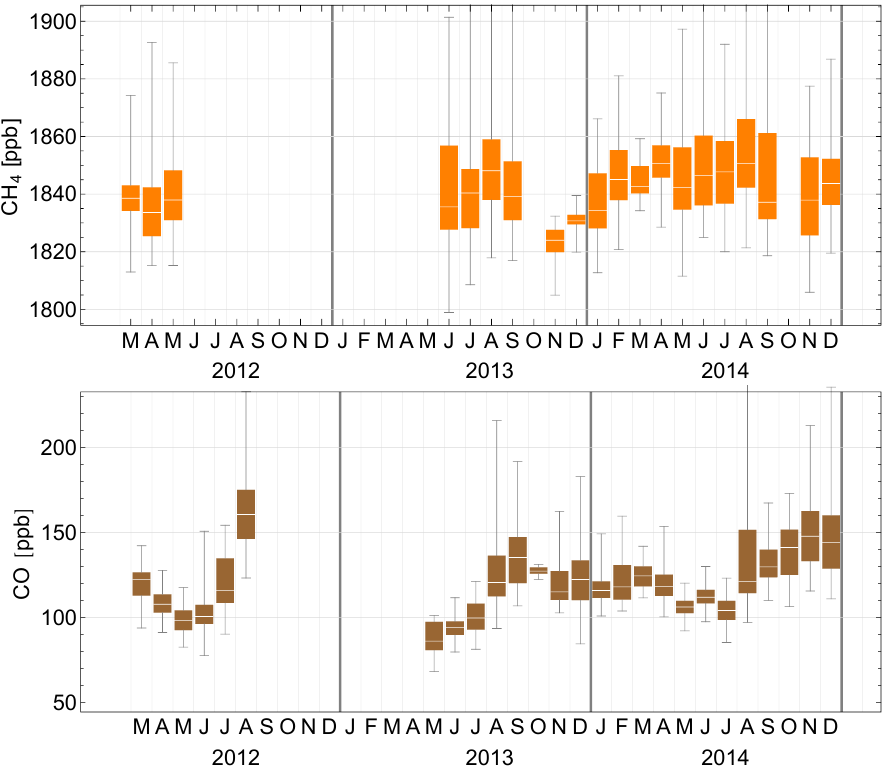
Figure 20. Statistics of monthly daytime (17:00–20:00UT) 30min measurements of CH 4 and CO at the 79m level of the 80m walk-up tower. Shown are whisker plots indicating min/max and quartiles of the monthly measurements. The white line in the box indicates the